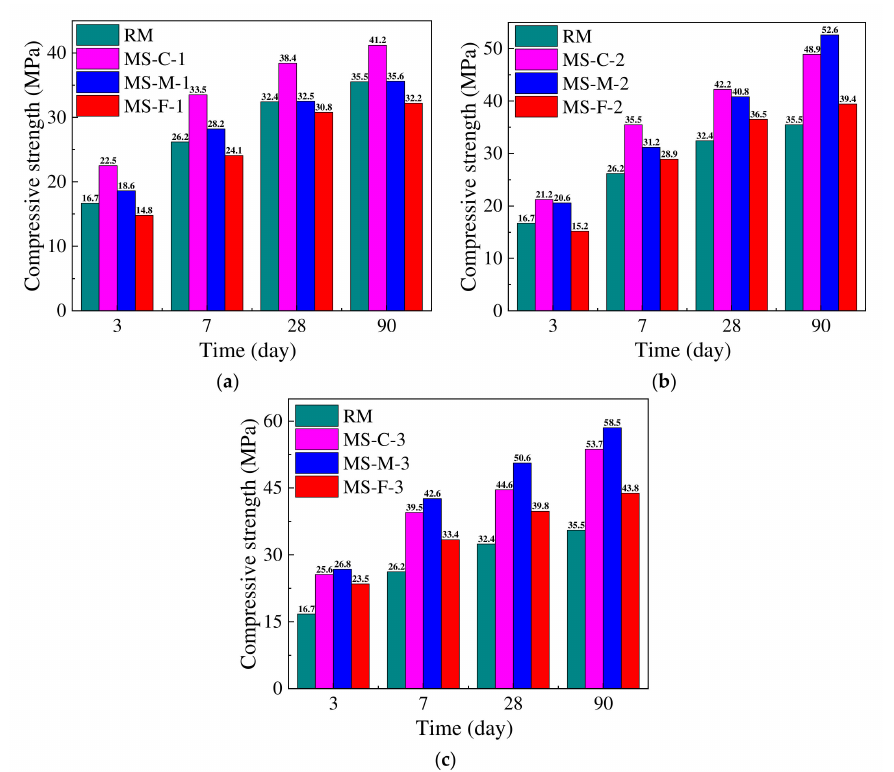
Figure 7. Influence of the admixtures on the HPC compressive strength. ( a ) HPC compressive strength of FA; ( b ) HPC compressive strength of FA and SF; ( c ) HPC compressive strength of FA, SF and RM.